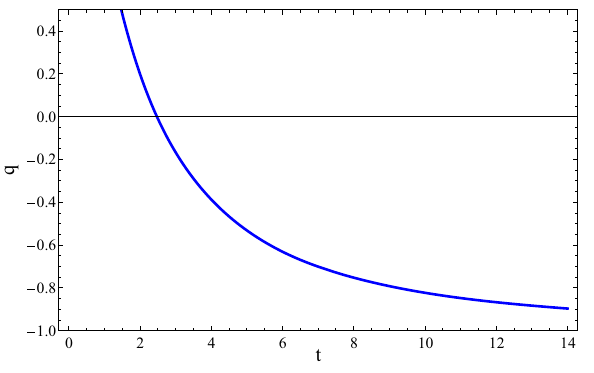
Fig. 1 Deceleration parameter vs. time